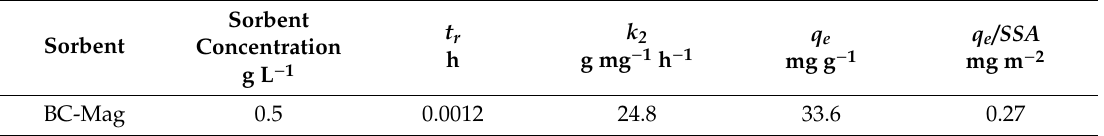
Figure 5. Time profile of carbamazepine sorption on BC-Mag 0.5 g L − 1 , solid lines are pseudo-second order kinetic model simulation. Table 2. Pseudo-second-order kinetic model parameters of carbamazepine sorption on BC-Mag. R 2 > 0.99 for all model